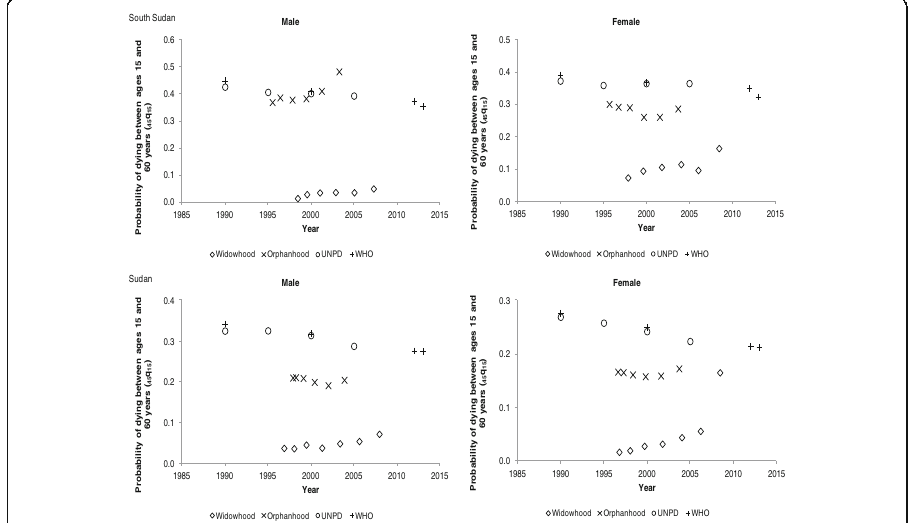
Fig. 4 Probability of dying between ages 15 and 60 years ( 45 q 15 ) by sex in South Sudan and